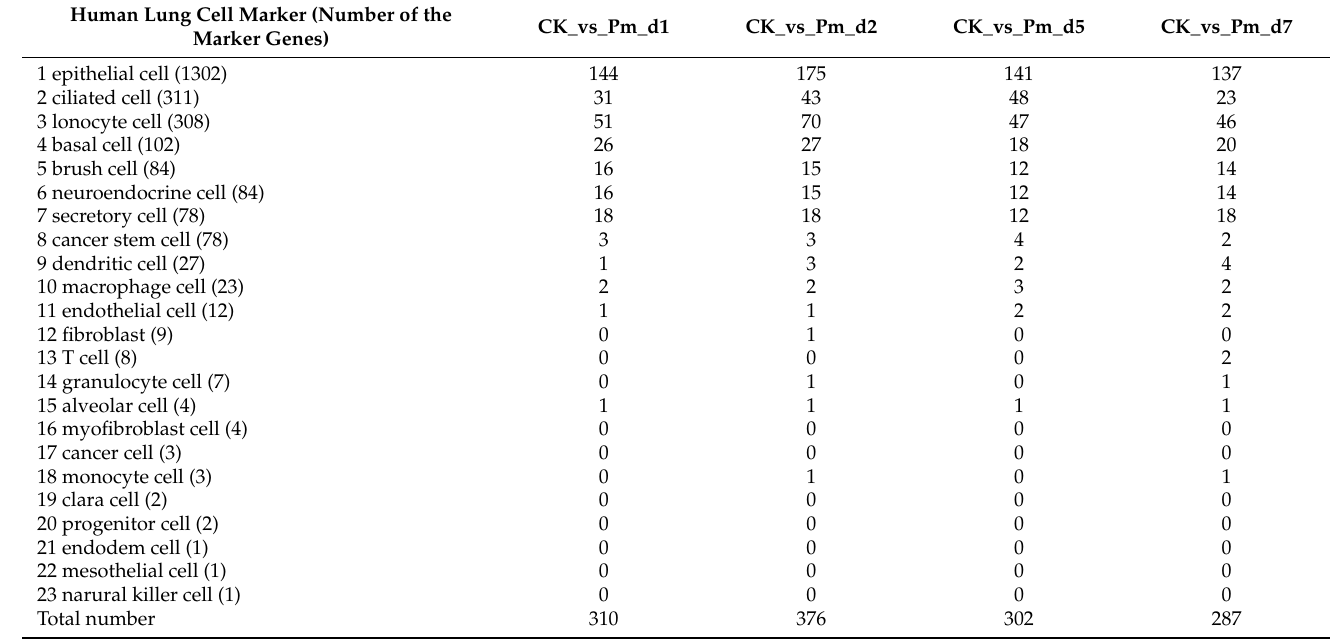
Table A3. The results of DEGs that mapped to the human lung cell marker gene.